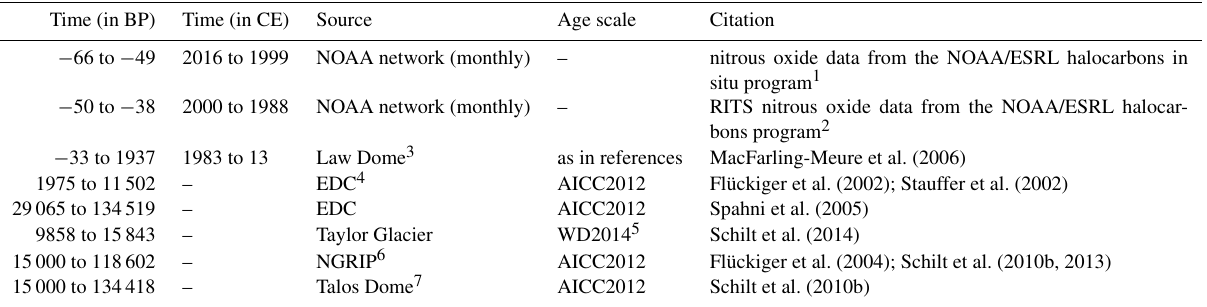
Table 7. Data used to construct the N 2 O